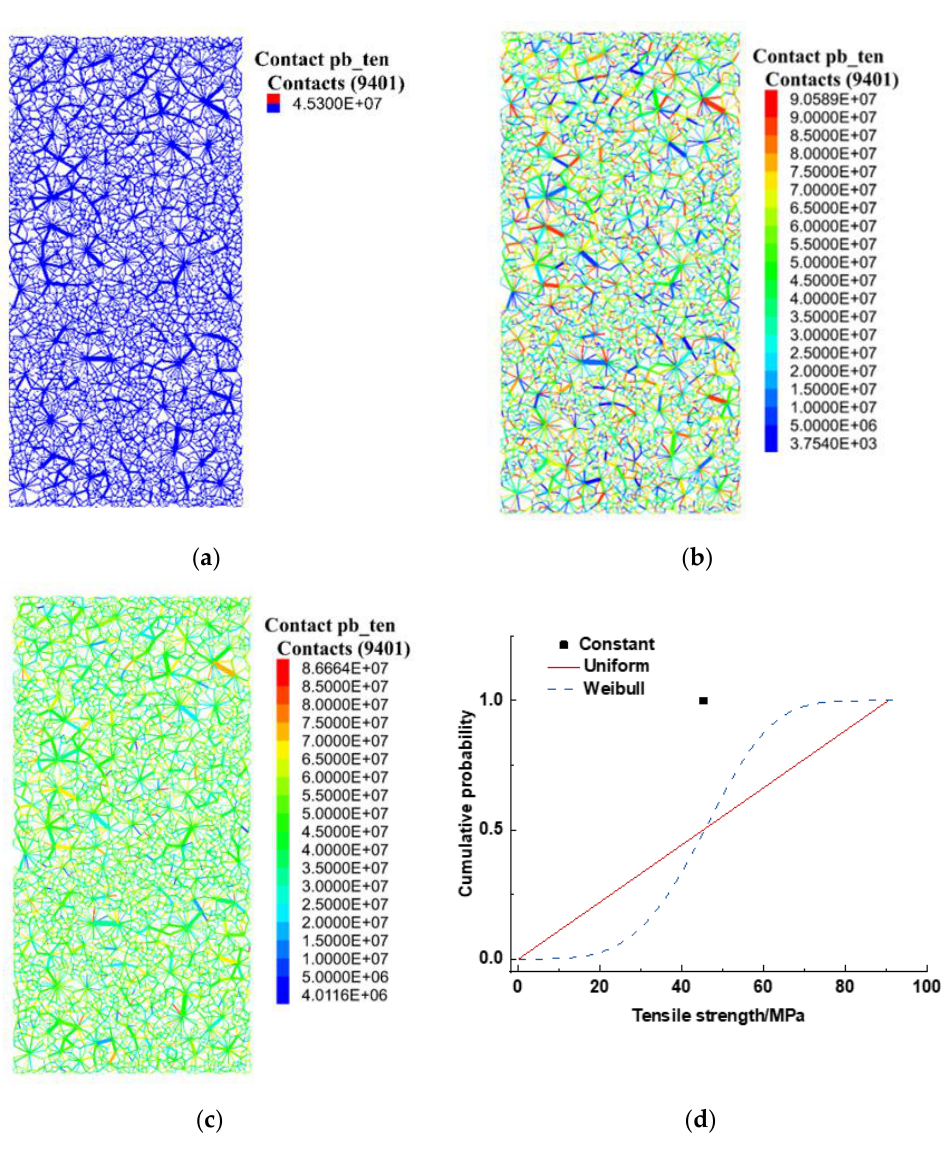
Figure 3. ( a ) Constant, ( b ) uniform, and ( c ) Weibull distributions of tensile strength in the models and ( d ) the tensile strength cumulative curves of the three cases.